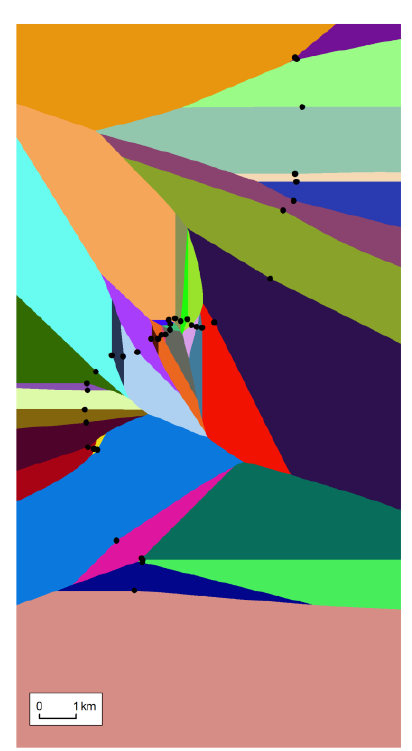
Figure 1. Segmented modelling area; colours are used just to separate different segments; black points are the points of given water levels